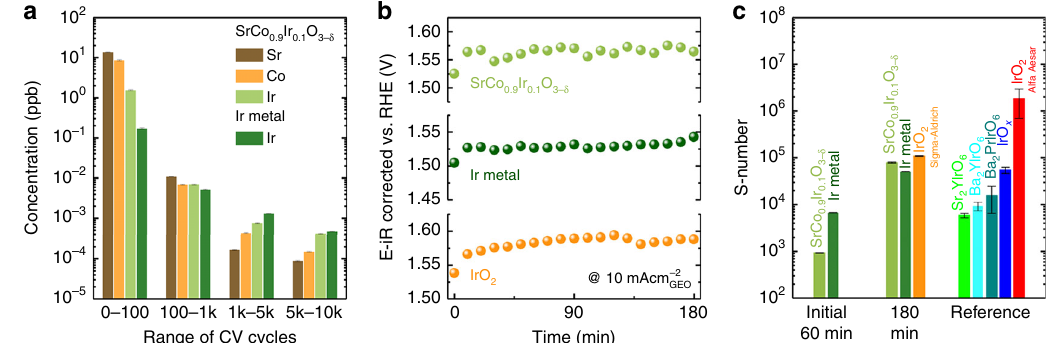
Fig. 5 Stability of SrCo 0.9 Ir 0.1 O 3 − δ . a The averaged concentration of dissolved cations per cycle at different stages. The scan rate is 1 V s − 1 . For the SrCo 0.9 Ir 0.1 O 3 − δ electrode, the potential range is 0.1 – 1.4 V (vs. RHE). As to the Ir metal electrode, to improve the Ir dissolution, the potential range for the initial 1k cycles and the rest 9k cycles is 0.1 – 1.6 V (vs. RHE) and 0.1 – 1.8 V (vs. RHE), respectively. Moreover, a higher overpotential (1.8 V vs. 1.6 V) applied